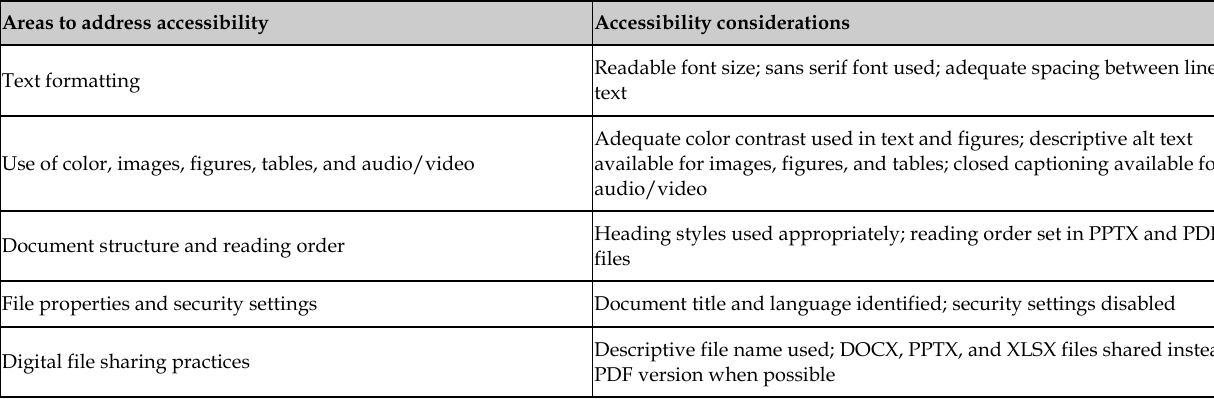
Table 1 Content from four step-by-step guides that provided instructions on fixing accessibility issues in documents and files (table is not comprehensive)